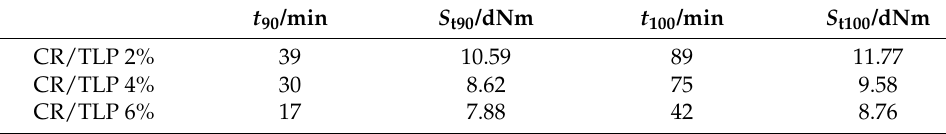
Table 2. t 90 and t 100 times and relative torque